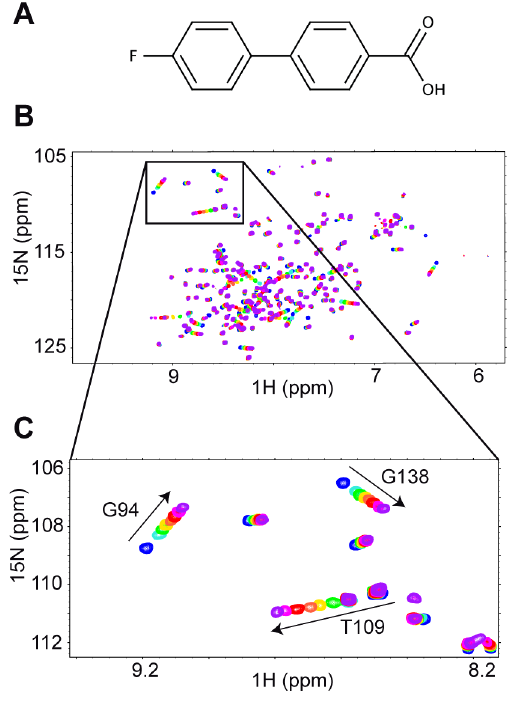
Figure 1. 15 N-HSQC spectra of the Bcl-xL protein in the presence of fragment 1. (A) Structure of fragment 1 . (B) Superimposition of the 15 N-HSQC protein spectra in the free state (blue) and in the presence of increasing ligand concentration (200 m M in cyan, 300 m M in green, 500 m M in yellow, 700 m M in orange, 1 mM in red, 2 mM in pink and 4 mM in purple). (C) Section of the 15 N-HSQC spectrum. Numeration was done according to the PDB code 1R2D. doi:10.1371/journal.pone.0064400.g001 contact with residues Phe97, Tyr101, Ala104, Phe105, Leu130, Gly138, Arg139 and Ala142 (Figure S1).